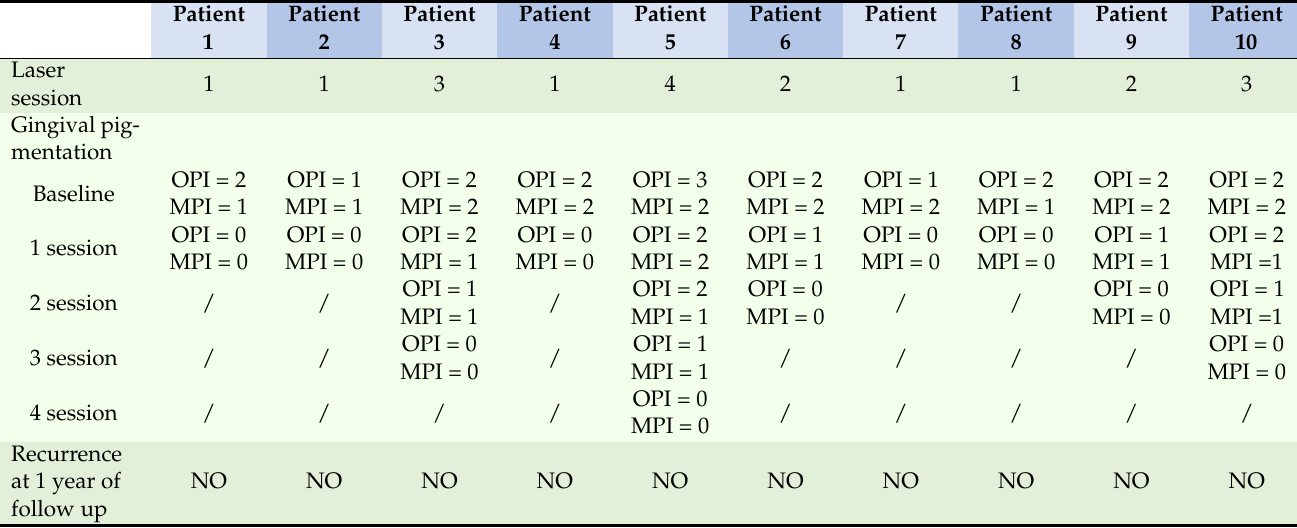
Table 3. Summary of clinical